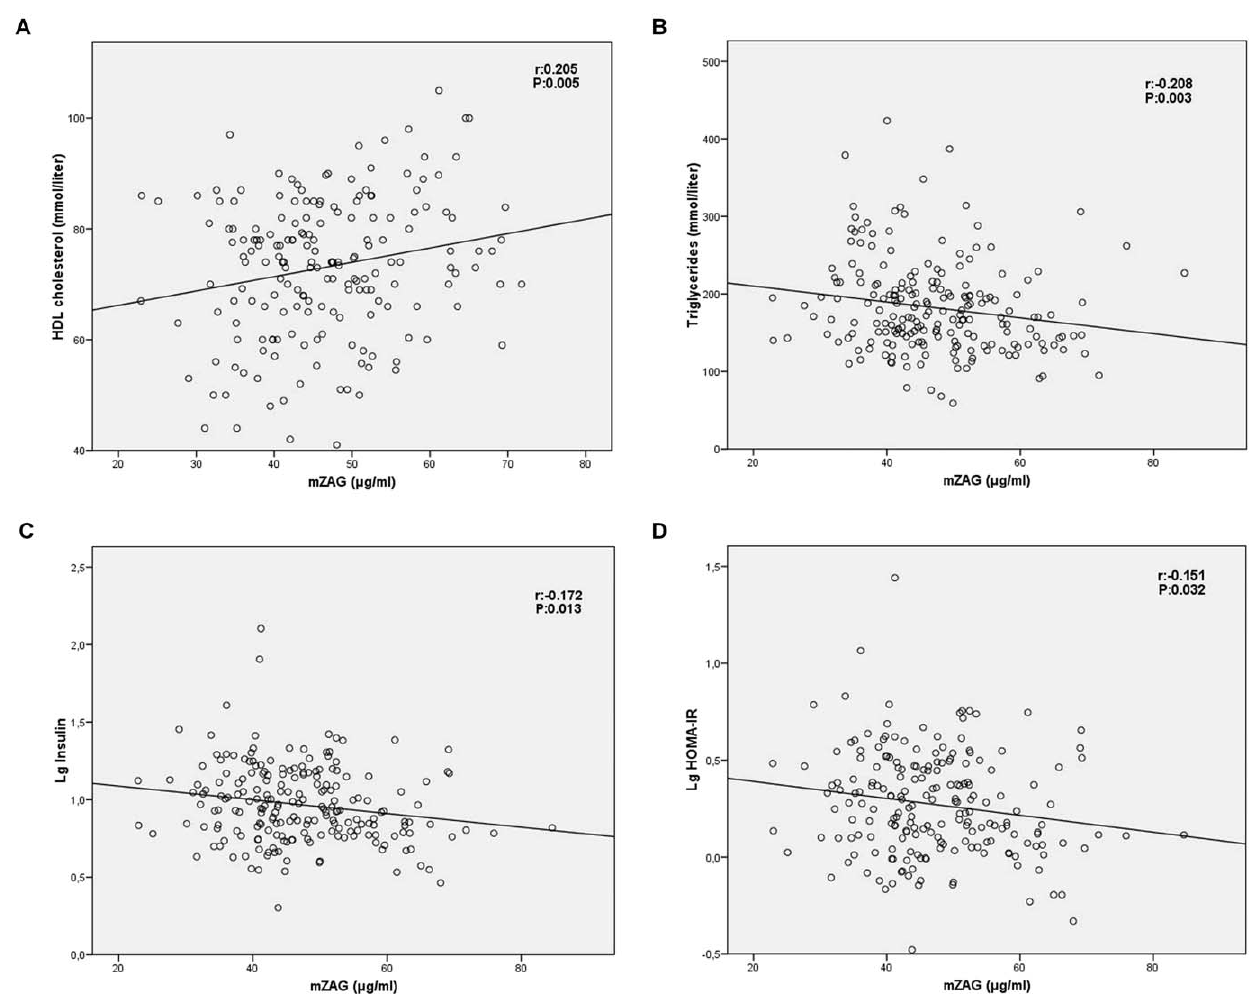
Figure 1. Correlation between serum mZAG levels and HDL cholesterol levels (A), triglyceride levels (B), Insulin logarithm (Lg Insulin) (C) and HOMA-IR logarithm (Lg HOMA-IR) (D).